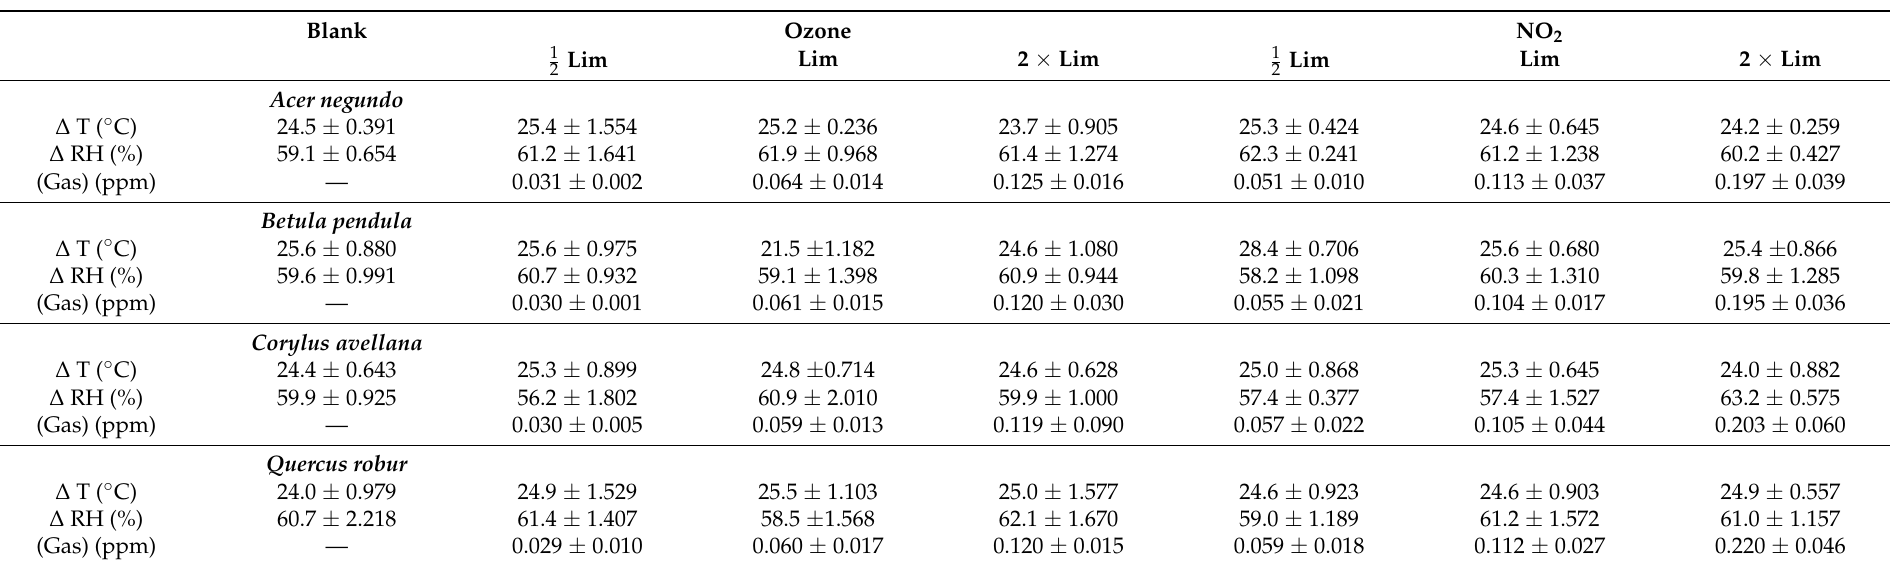
Table 1. Average and standard deviation values of temperature, relative humidity and gas concentrations obtained inside the fumigation chamber for each assay. Blank Ozone NO 2 1 Lim 2